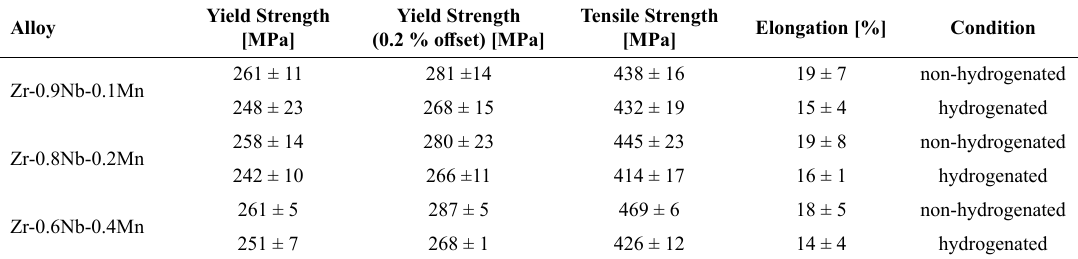
Table 3. Tensile test results for Zr-0.9Nb-0.1Mn, Zr-0.8Nb-0.2Mn and Zr-0.6Nb-0.4Mn before and after hydrogenation.